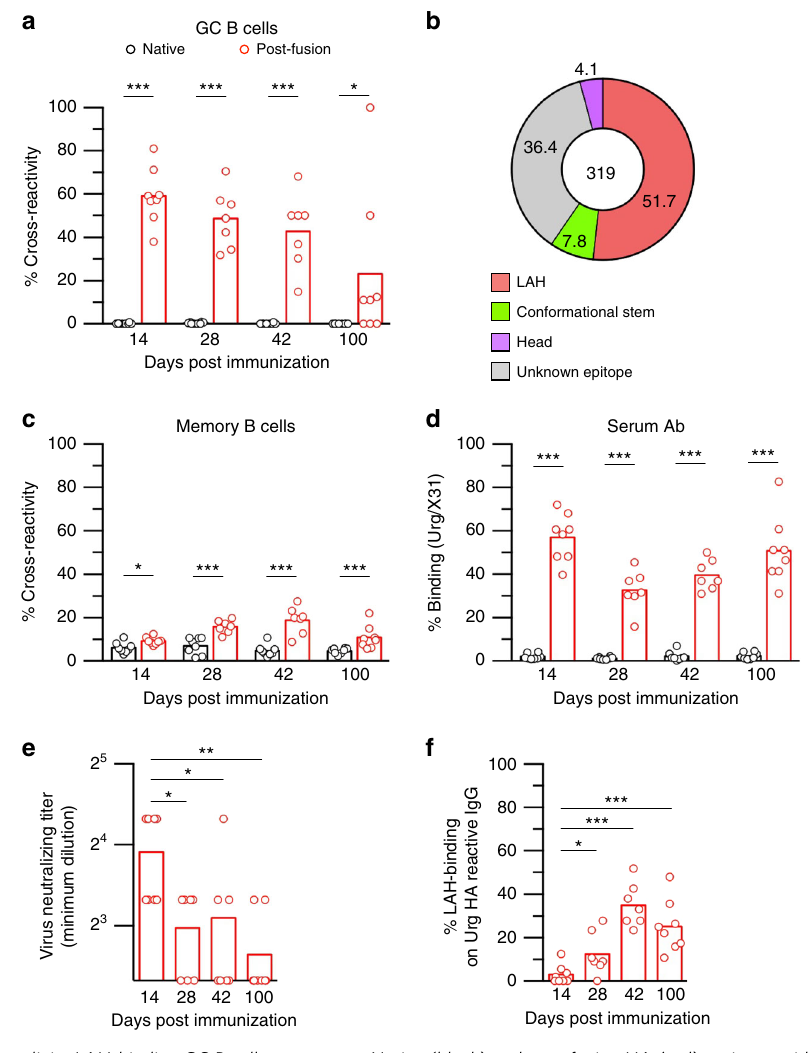
Fig. 5 Post-fusion HA antigen elicits LAH-binding GC B cell responses. a Native (black) and post-fusion HA (red) antigens with AddaVax adjuvant were i.p. injected into the mice. At the indicated time points, cross-reactivity of HA-binding GC B cells in spleens was enumerated by fl ow cytometry. b High- throughput epitope mapping analysis identi fi ed multiple classes of conserved epitopes for cross-reactive GC B cells in mice at day 14 after immunization with post-fusion HA. The data from pooled 9 mice is shown. c Cross-reactivity of HA-binding memory B cells were enumerated from the same mice by fl ow cytometry. d IgG titers against X31 HA and Urg HA were determined by ELISA and the binding ratios were plotted. e Serially diluted immune sera were subjected to microneutralization assay using Urg strain as challenging virus. f Ratios of LAH-binding IgG among Urg HA-binding IgG were evaluated by competitive ELISA. Each dot represents the result of an individual mouse. The combined data from two independent experiments are shown. The P -values were determined with a two-tailed Mann – Whitney test. * P < 0.05; ** P < 0.01; *** P < 0.001. Source data are provided as a Source Data fi